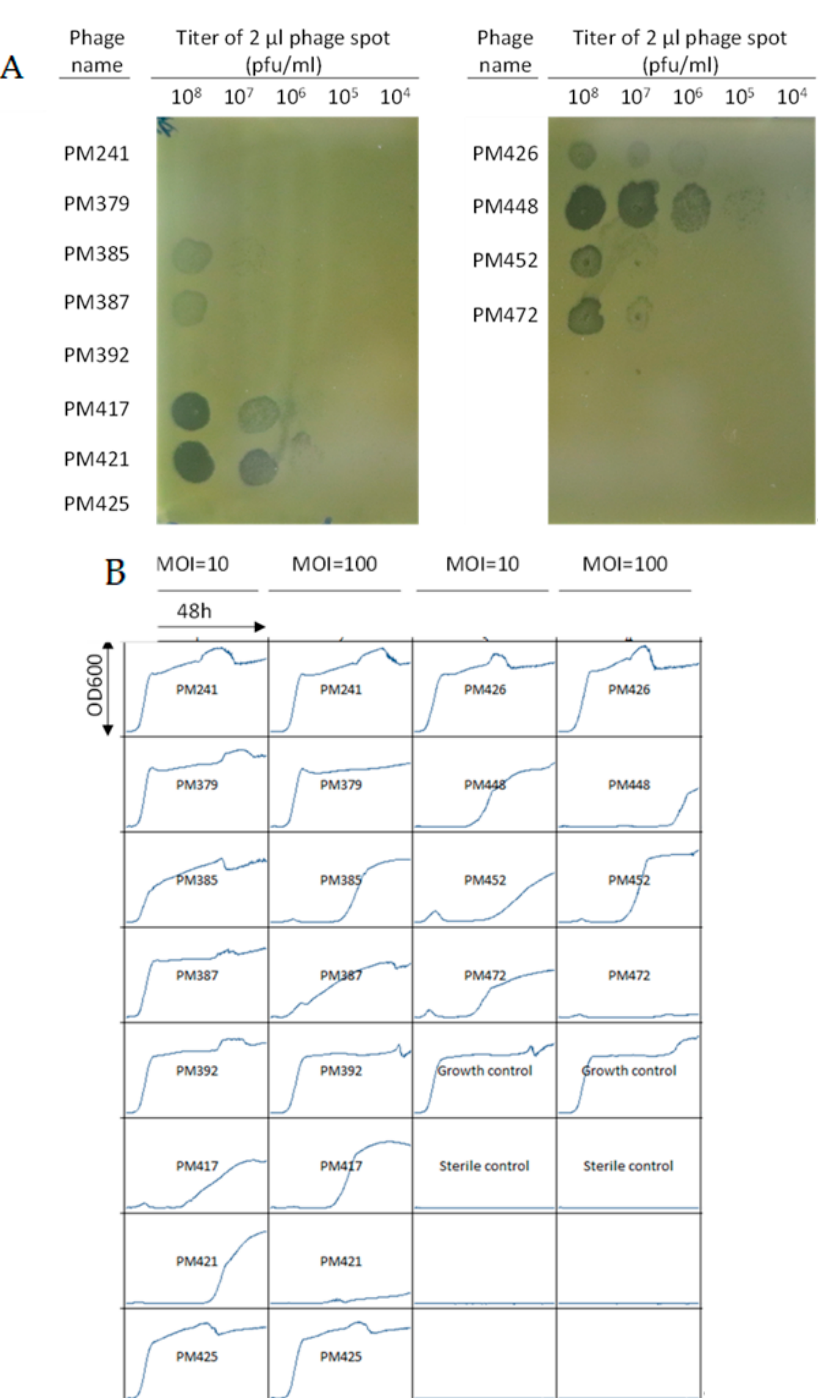
Figure 3. ( A ) Plaquing test by the BHI agar overlay method. A total of 2 µ L of the E 2 -phages indicated on the left at 10 8 pfu/mL were spotted onto a top agar layer containing 10 8 colony forming units/mL of this patient’s S. epidermidis isolate. ( B ) “Growth inhibition” curves for the same E 2 -phages as in ( A ) with the various bacteriophages to this patient isolates S. epidermidis clinical isolate. Different bacteriophages are indicated by PM241-PM472. MOI refers to multiplicity of infection. Growth control is the clinical isolate with no bacteriophages. Each box has time on the x -axis with end point being 48 h and the optical density (OD) at 600 nm on the y